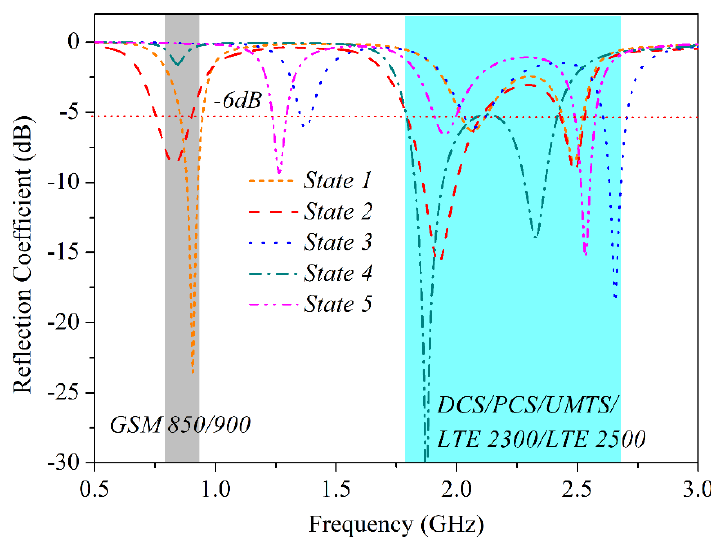
Figure 8. Five |S 11 | states of the proposed T-shaped antenna: State 2 for lower bands and the other four states for mid and high bands.